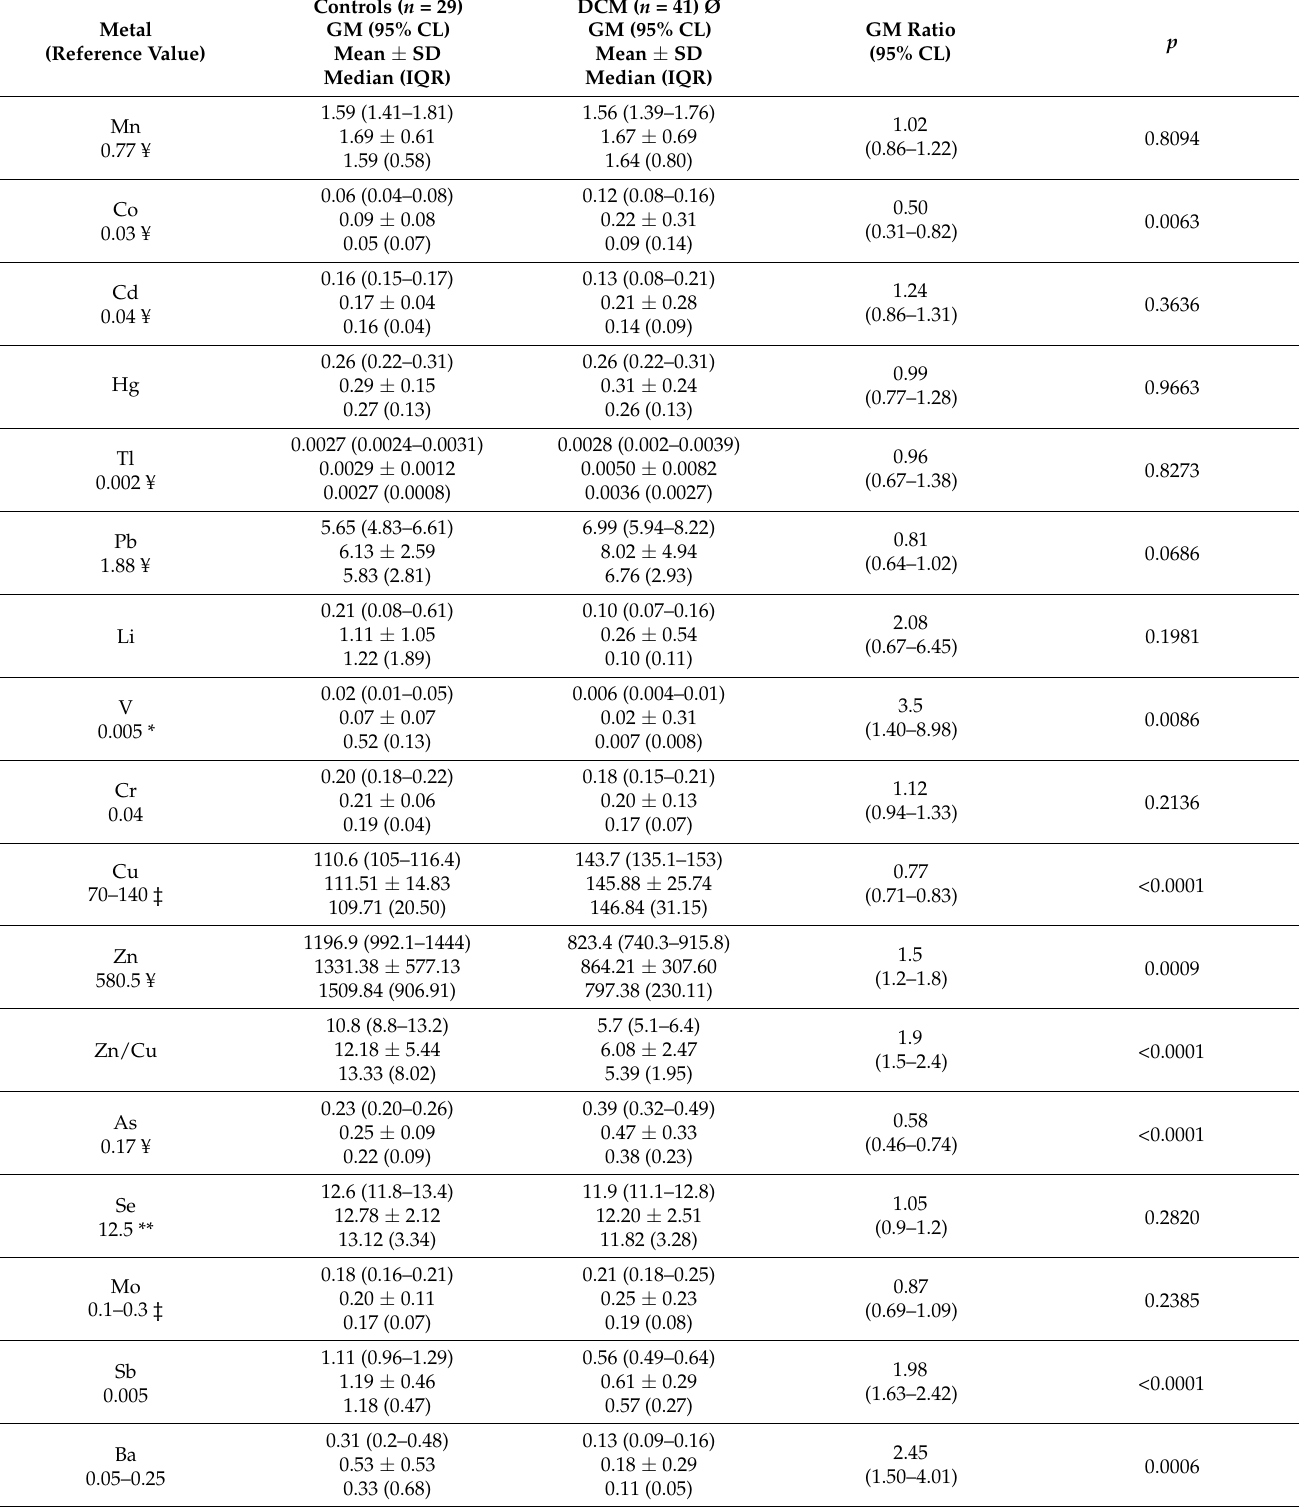
Table 1. Concentrations ( µ g/dL) of blood heavy metals in patients compared to